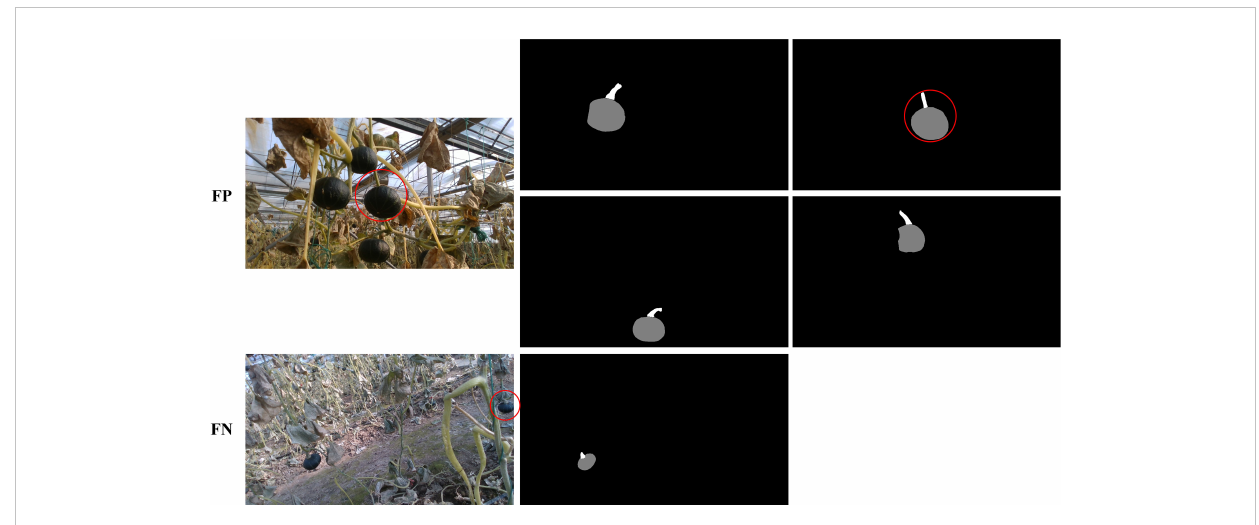
FIGURE 14 Wrong examples of pumpkin fruit and stem matching result.